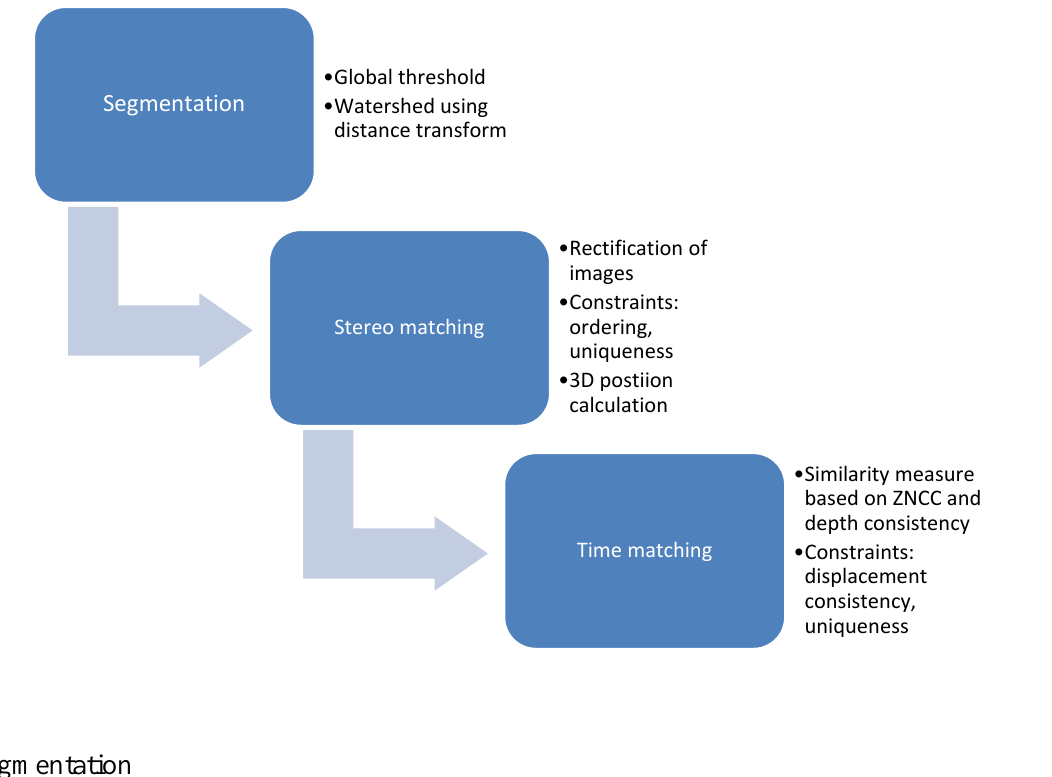
Figure 1. Steps of the 3D position and motion estimation